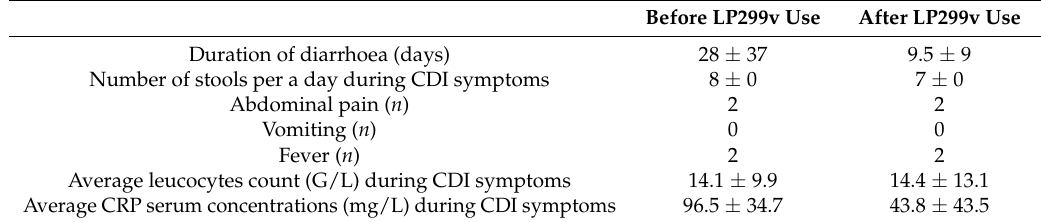
Table 7. The analysis of the clinical features of the recurrence of CDI in two patients before and after initiation of LP299v prophylaxis. The above-mentioned periods lasted twelve